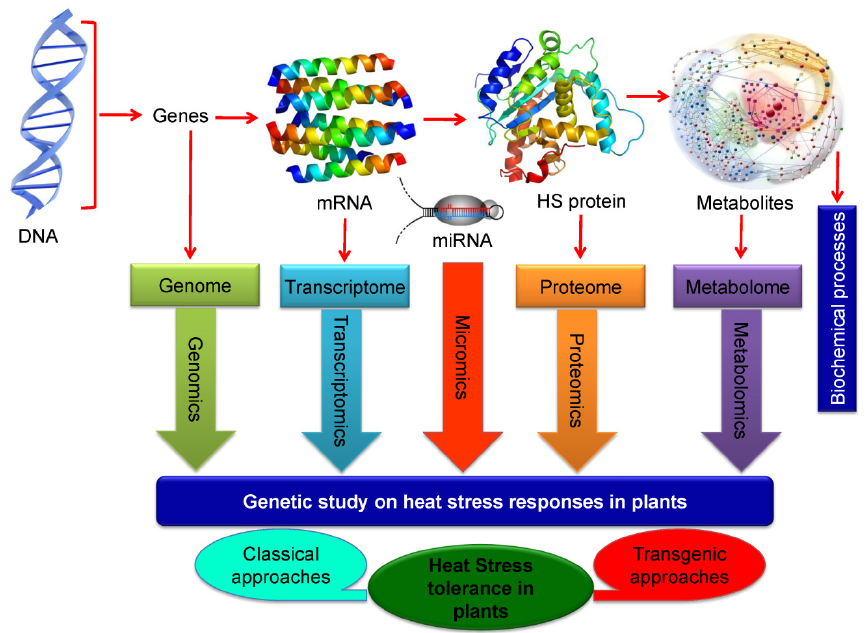
Figure 7. Diagram representing integrated circuit of different “omics” approaches that are connected to each other at molecular genetic level associated with heat stress tolerance in